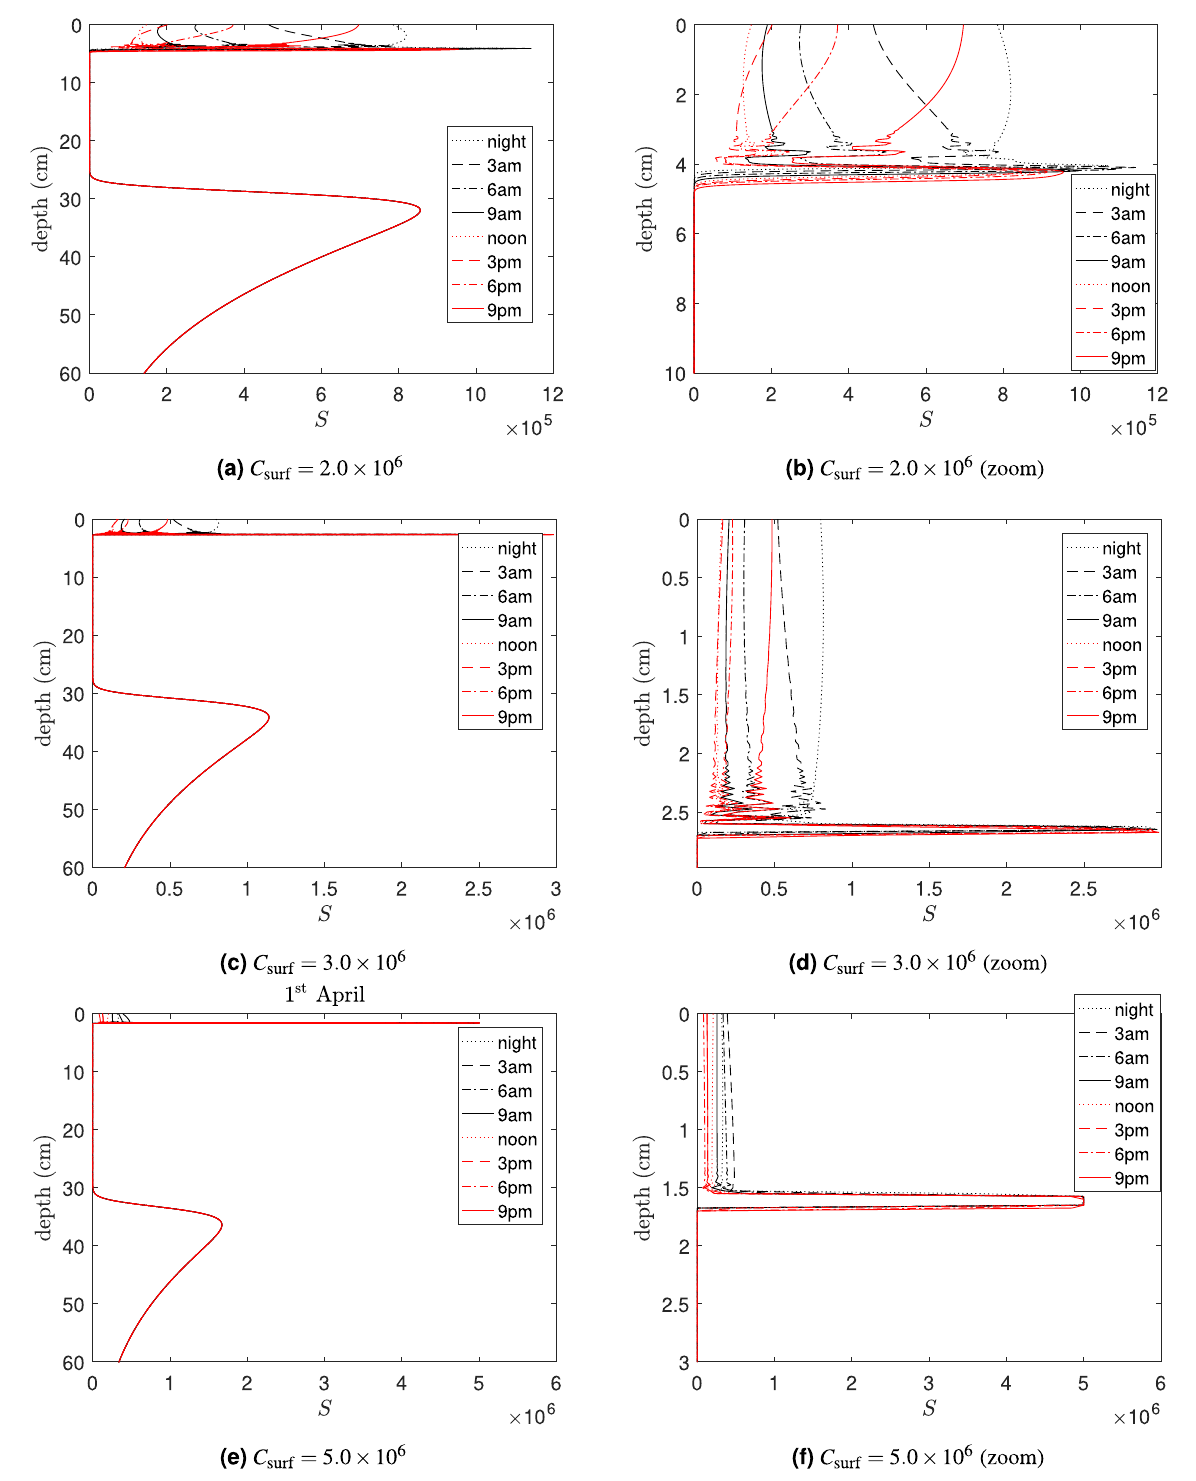
Figure 7. Influence of the carrying capacity on the vertical distribution of susceptible bacteria S in the soil predicted by the model calculated for Nakhon Phanom province. The left panel shows vertical distributions in the top 60 cm whereas the right panel presents zooms of the same profiles near the surface. The corresponding values of C surf (measured in cell/ml) are provided in figures. The graphs show the spatial distributions predicted for April 1st. The unit of the density of S is